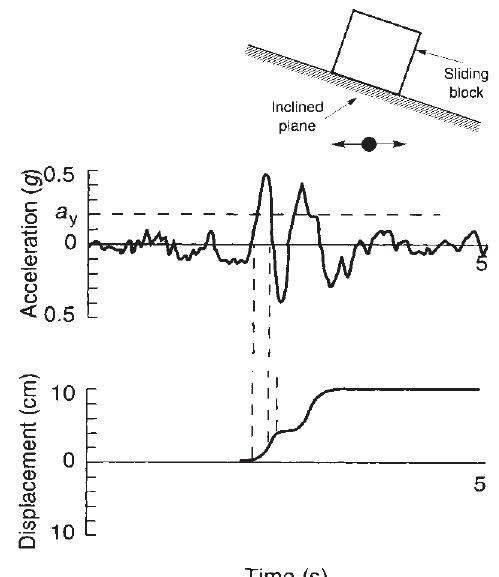
Fig. 4. Newmark sliding block